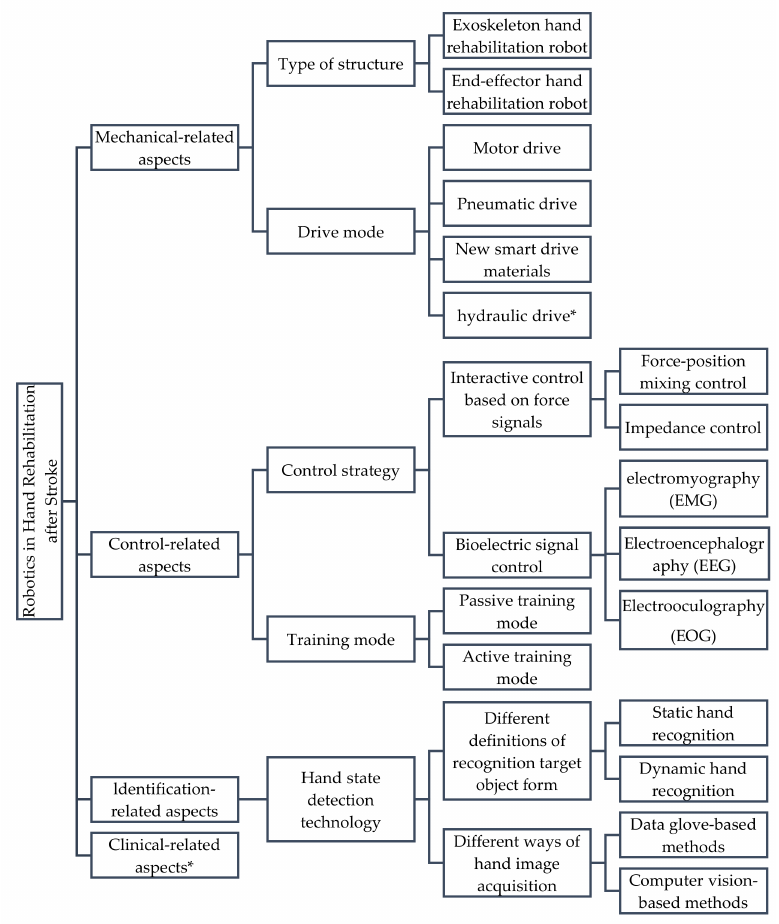
Figure 2. The basic outline of the contents is covered in this paper. The aspects marked with an asterisk (*) are beyond the scope of this